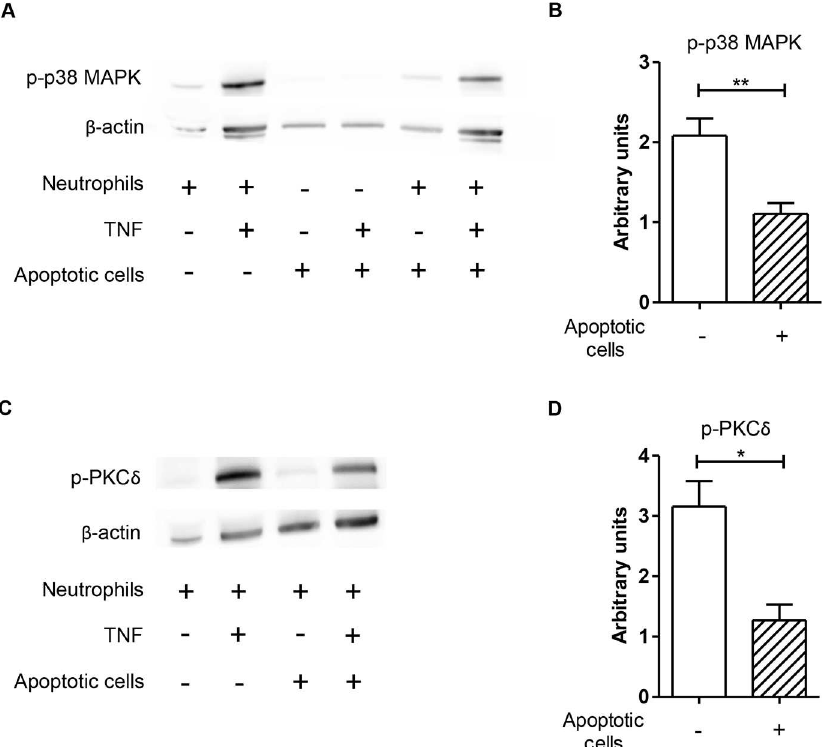
Fig 4. Co-incubation with apoptotic cells results in diminished TNF-induced phosphorylation of PKC δ and p38-MAPK in neutrophils. Freshly isolatedneutrophilswere incubatedin the absenceor presenceof apoptotic cells for 90 min prior to stimulationwith TNF- α for 15 min, and the phosphorylation of p38-MAPK and PKC δ was assessedby western blot. A representative blot of phosphorylated p38-MAPK (A) and PKC δ (C) are shown. Data were quantified and normalized to β -actin (B and D). Data are shown as mean ± SEM of three-four independentexperiments; * p (cid:20) 0.05, ** p (cid:20)